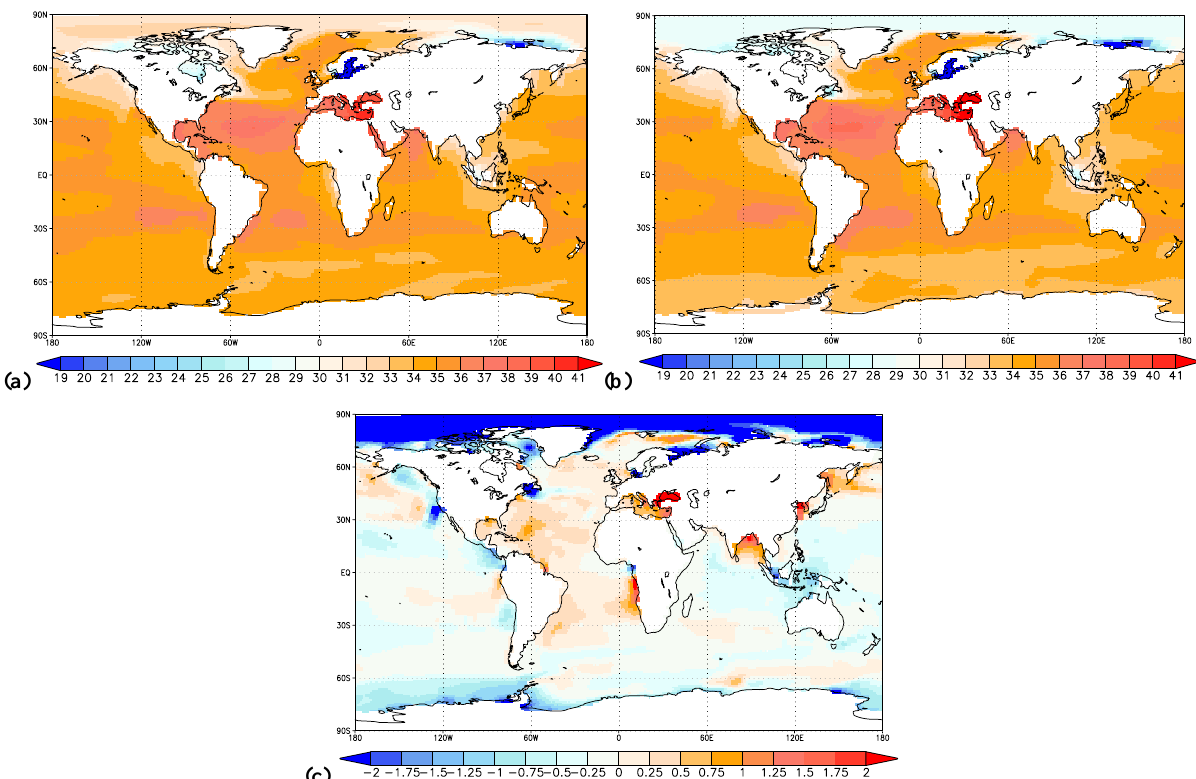
Fig. 13. Annual mean sea surface salinity in psu in experiment 2, calculated from a 30-yr climatology that has been interpolated to a regular 360 ◦ × 180 ◦ grid. Shown are the PI control simulation (a) , the mid-Pliocene simulation (b) , as well as the anomaly between mid-Pliocene and PI control (c) .